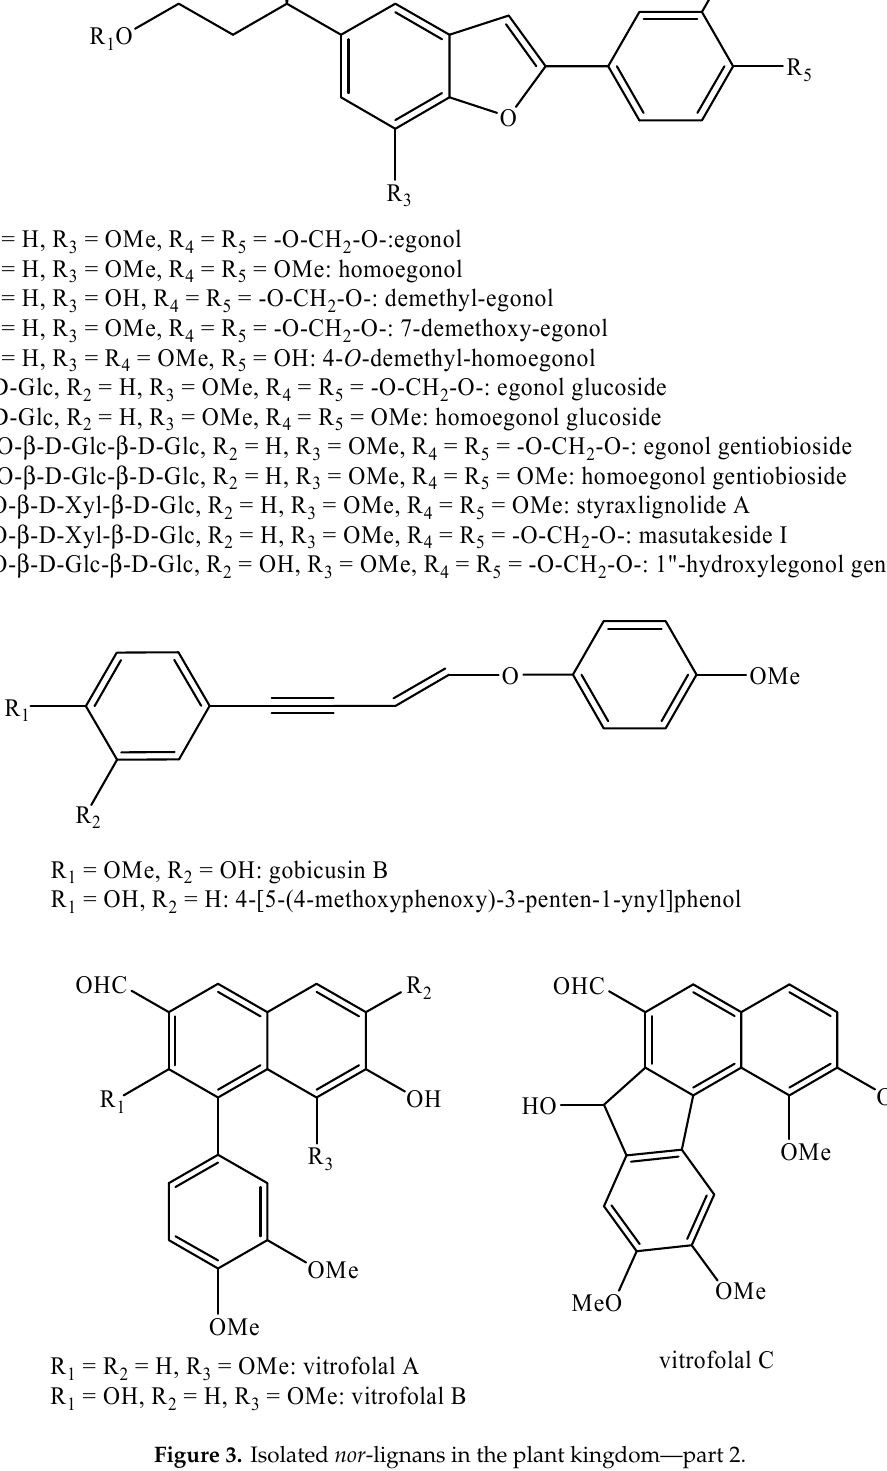
Figure 3. Isolated nor -lignans in the plant kingdom—part 2.